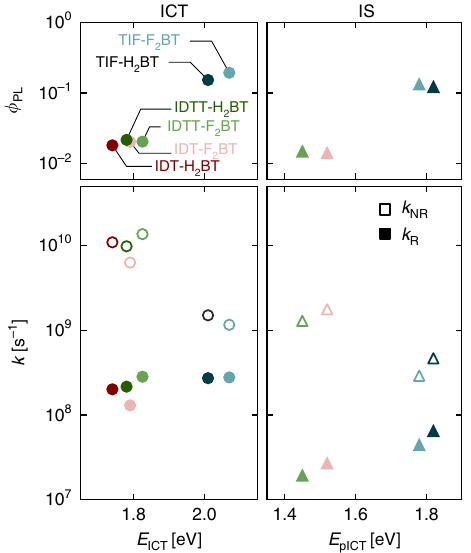
Fig. 5 Extracted recombination parameters. Intra-chain ICT (circles) and interchain pICT (triangles) excitons parametrised in terms of the luminescence energy E : PLQE of the transition, rates of recombination, colour-coded by